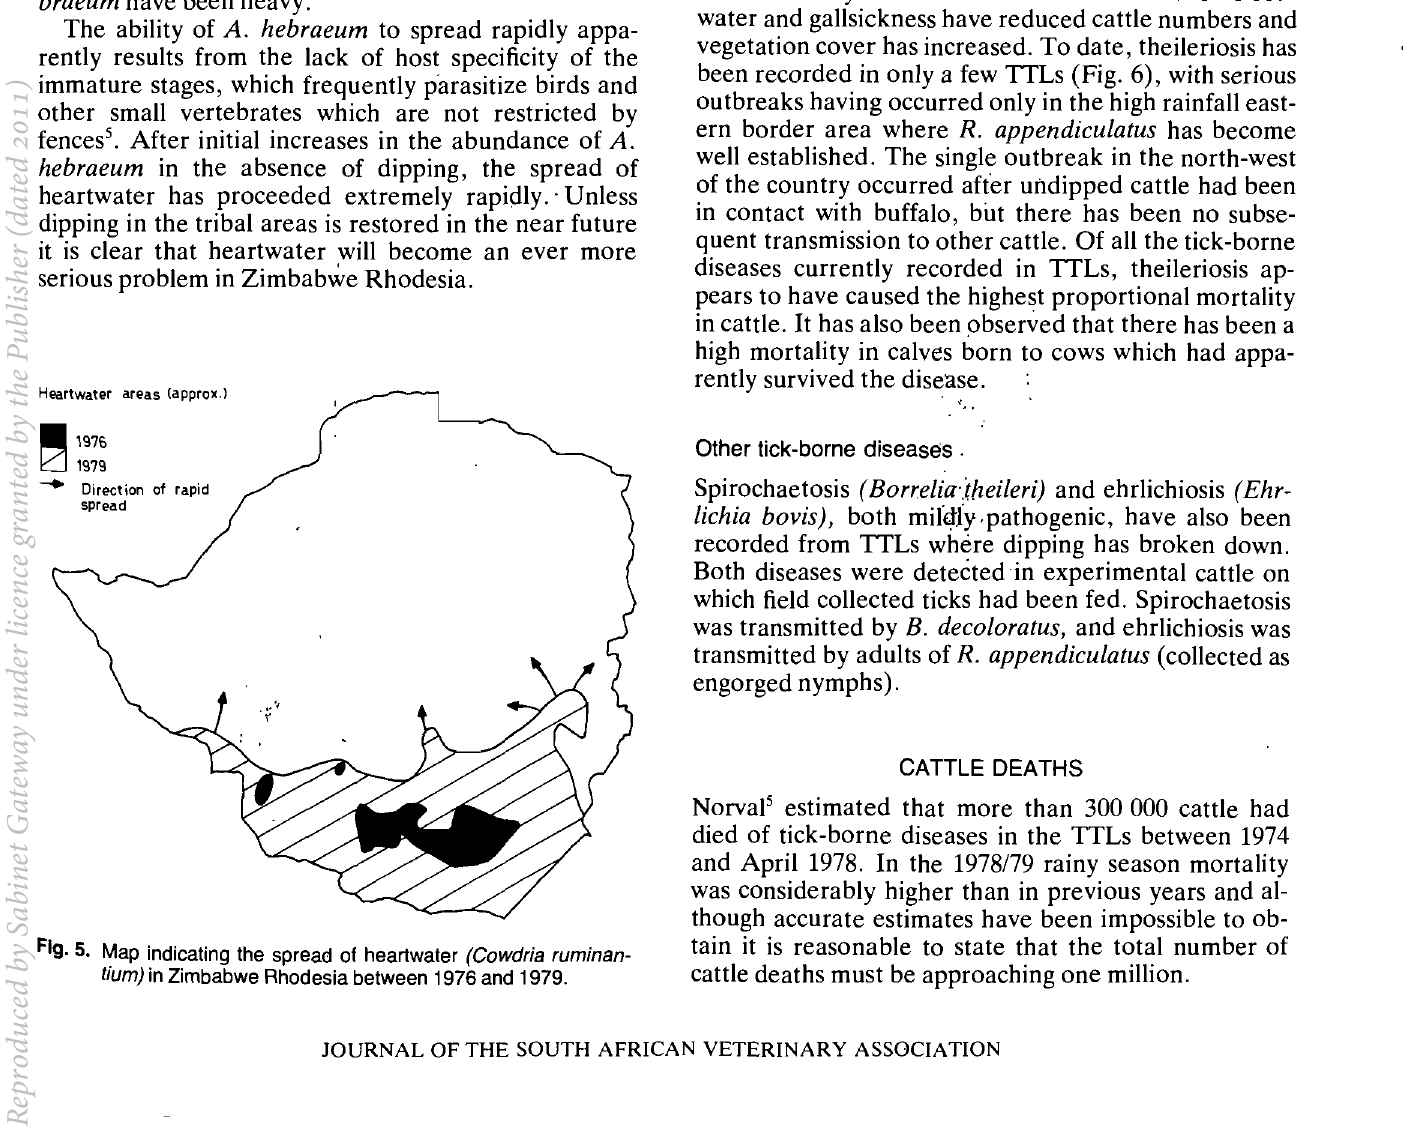
Fig. 5. ~ap i.ndicating the spread of heartwater (Cowdria rurninan t/Urn) In Zimbabwe Rhodesia between 1976 and 1979.